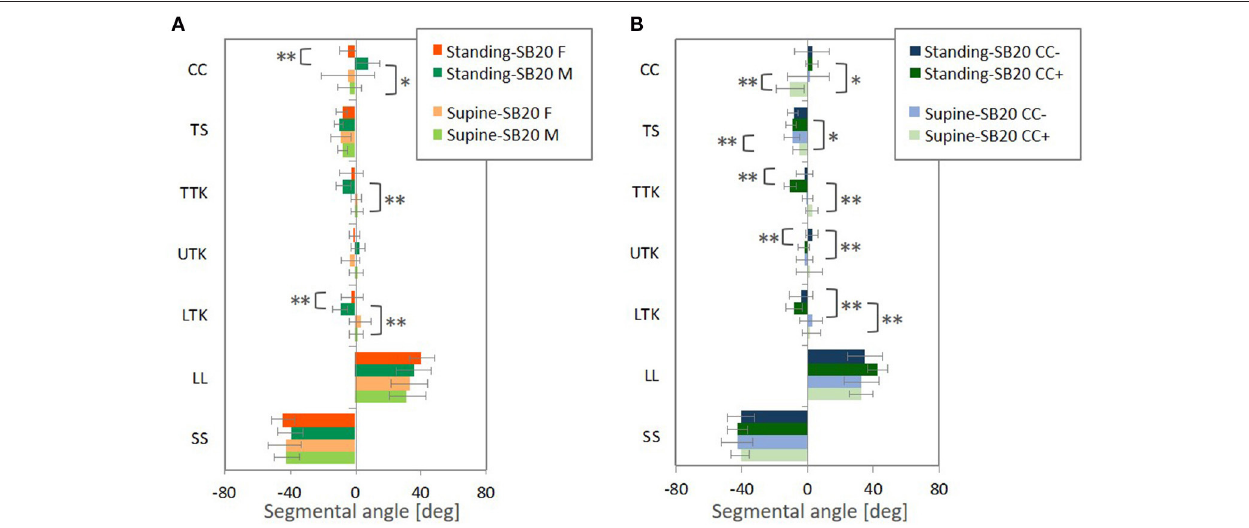
FIGURE 12 | The average with standard deviation and p -value from t -test (** < 0.05, * < 0.1) for differences of the segmental angles in the standing and supine postures relative to the seating posture with the 20 ◦ seatback angle, (A) comparing male and female subjects (M and F) and (B) the negative CC (CC − ) and positive CC (CC + ). Differences were calculated by subtracting the segmental angles in the seating posture from the segmental angles in the standing or supine posture,